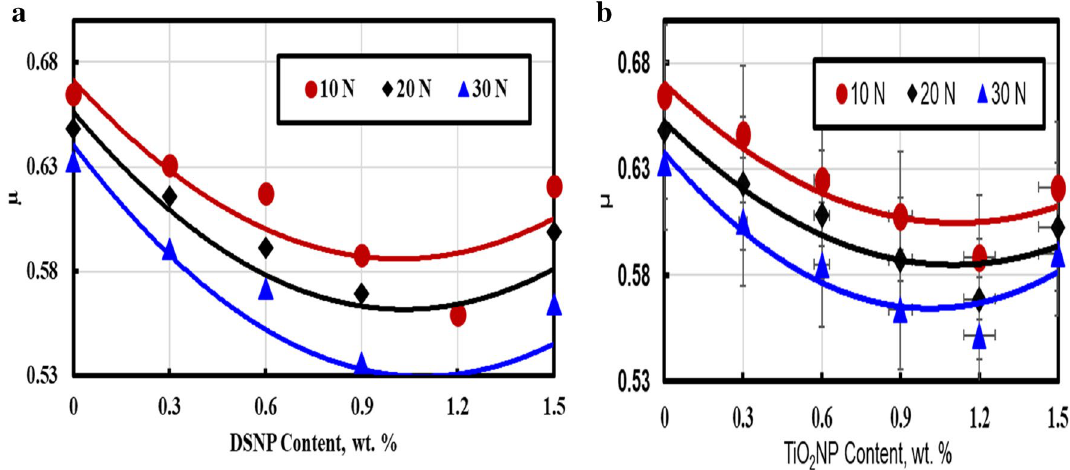
Figure 5. Coefficient of friction as a function of the filler weight and load for the tested nanocomposites: ( a ) PMMA/DSNP, and ( b ) PMMA/TiO 2